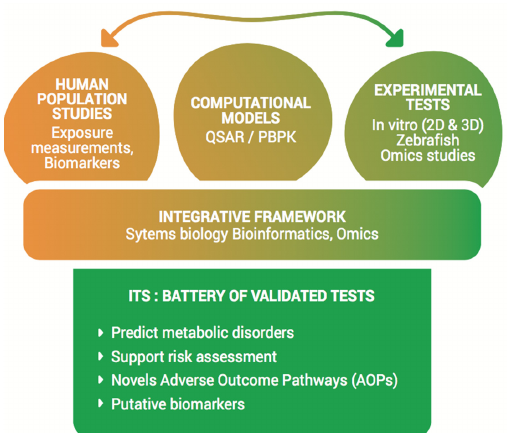
Figure 1. The OBERON platform. The OBERON project aims to establish an innovative integrated approach for testing and assessment (IATA) by providing a battery of effective and validated test systems for endocrine disruptor (ED) assessment on metabolic disorders. Multidisciplinary data and model systems, already existing or that will be developed within the OBERON consortium, will be integrated in order to perform predictive toxicology for EDs. Abbreviations: Quantitative Structure Activity Relationships (QSAR), Physiologically Based PharmacoKinetic (PBPK), Integrative Testing Strategy (ITS), Adverse Outcome Pathways (AOPs). Table 1. The ten chemicals studied in OBERON.